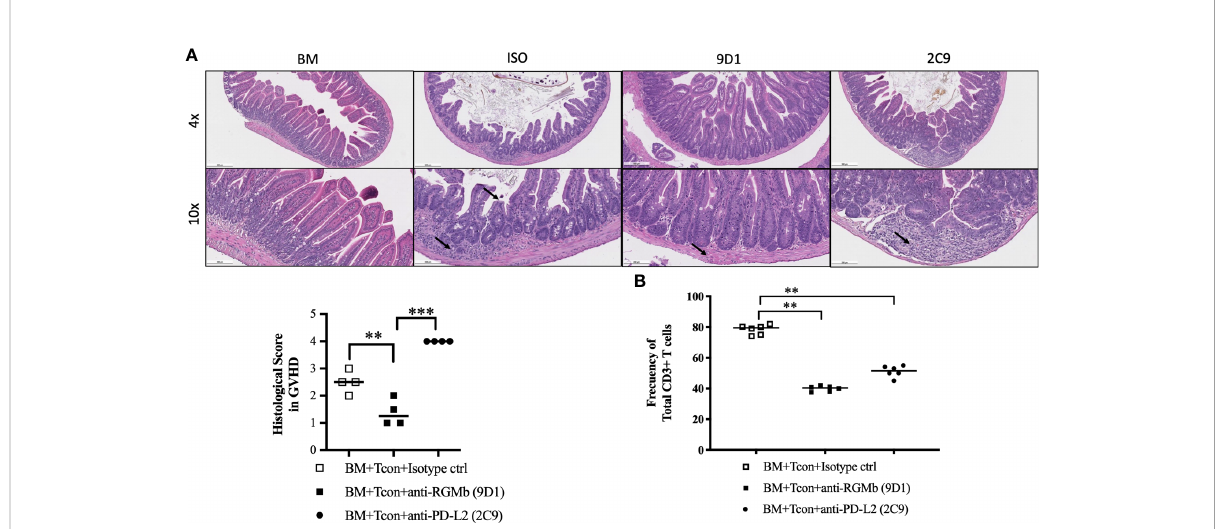
FIGURE 2 Treatment with anti-RGMb antibody 9D1 reduces GvHD. (A) Large intestine histopathology was assessed by H&E staining on normal, isotype control, 9D1- and 2C9-antibody-treated mice (20 mg/Kg; i.p.) at 9 days after BM transplantation. Histology is shown at 4x (scale bar 500 m m) and 10x (scale bar 200 m m) and histology score in GVHD is shown. Small arrows represent in fl ammatory in fi ltrate and crypt structure. (B) CD3 + T cell numbers of gut CD45 + cells were calculated by fl ow cytometry. Results are expressed as mean ± SEM (n ≥ 5/group). ** p ≤ 0.01, *** p ≤ 0.001, One-way ANOVA